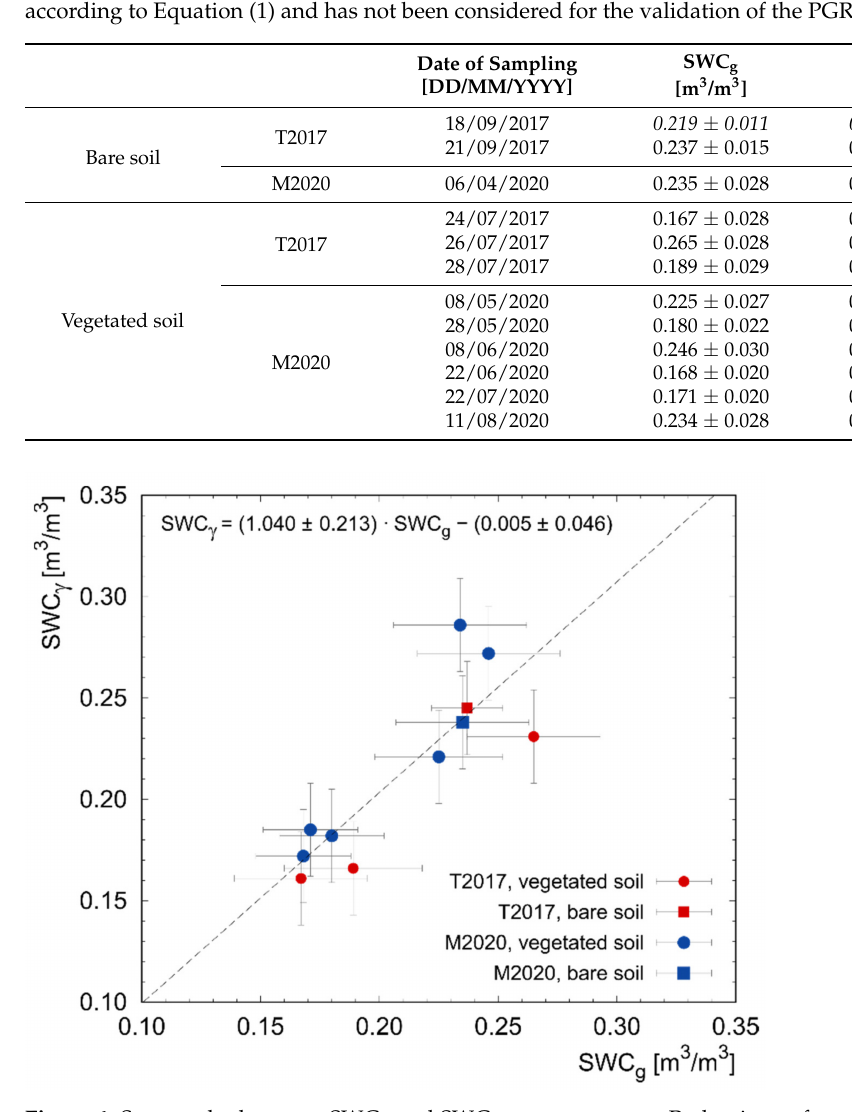
Figure 4. Scatter plot between SWC g and SWC γ measurements. Red points refer to measurements performed during T2017, while the blue ones represent data points acquired in M2020.